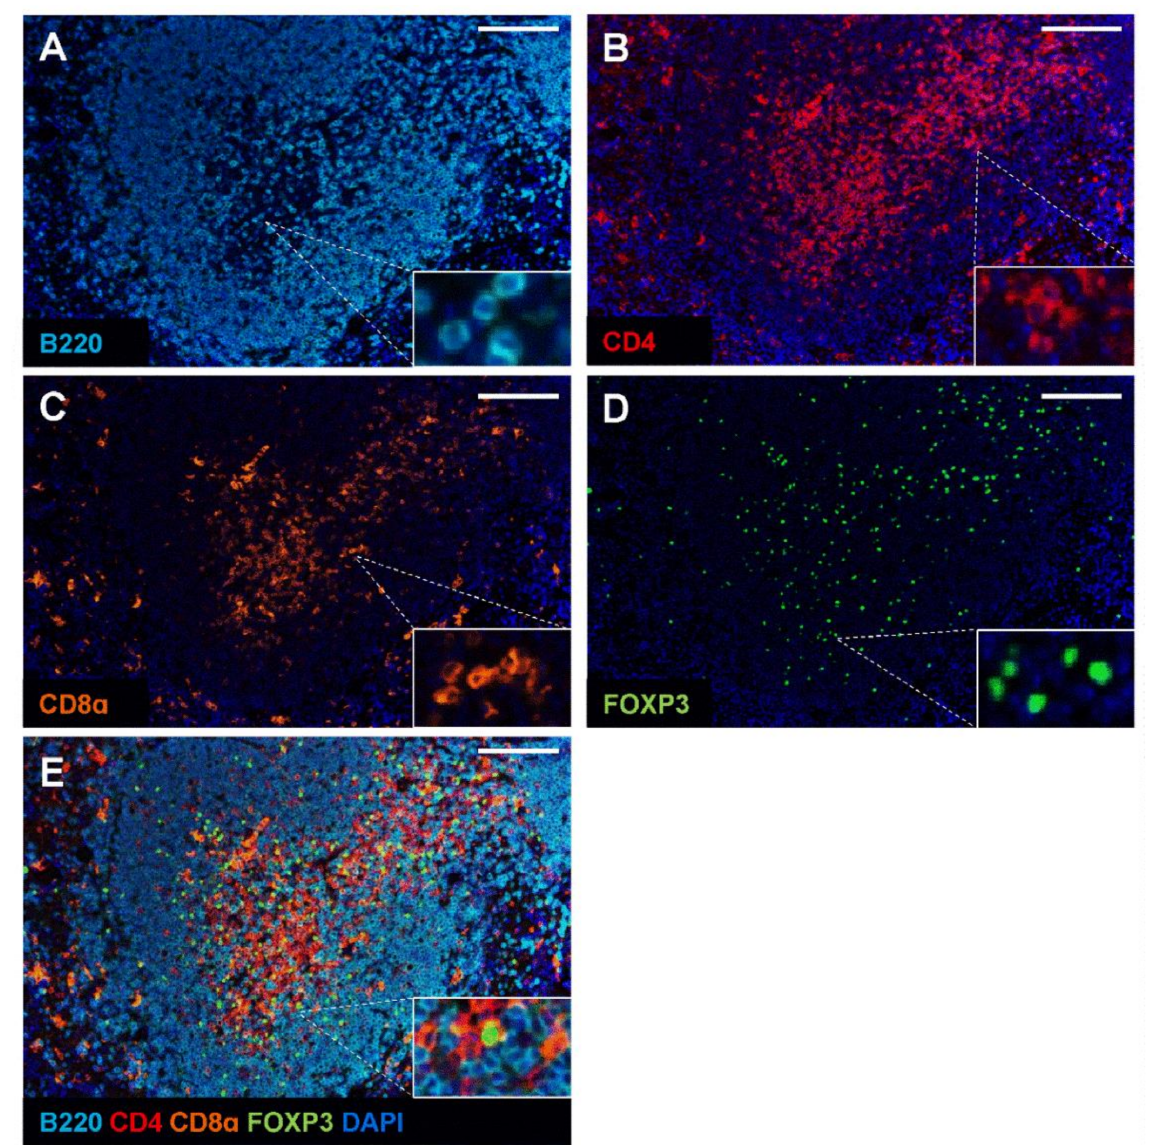
Figure 4. Validation of multiplex immunohistochemistry on FFPE mouse spleens. The optimised multiplex staining protocol was performed on formalin-fixed paraffin-embedded (FFPE) C57Bl/6 mouse spleen sections. Slides were stained with B220, CD4, FOXP3 and CD8 α antibodies in that order with low pH glycine-based stripping buffer or Tris-EDTA antigen retrieval in between. Representative images of each channel ( A – D ) and the merged image ( E ) are shown. Tissue sections were imaged at 20 × magnification on Vectra 3. B220 (cyan); CD4 (red); CD8 α (orange); FOXP3 (green). Scale bar: 100 µ